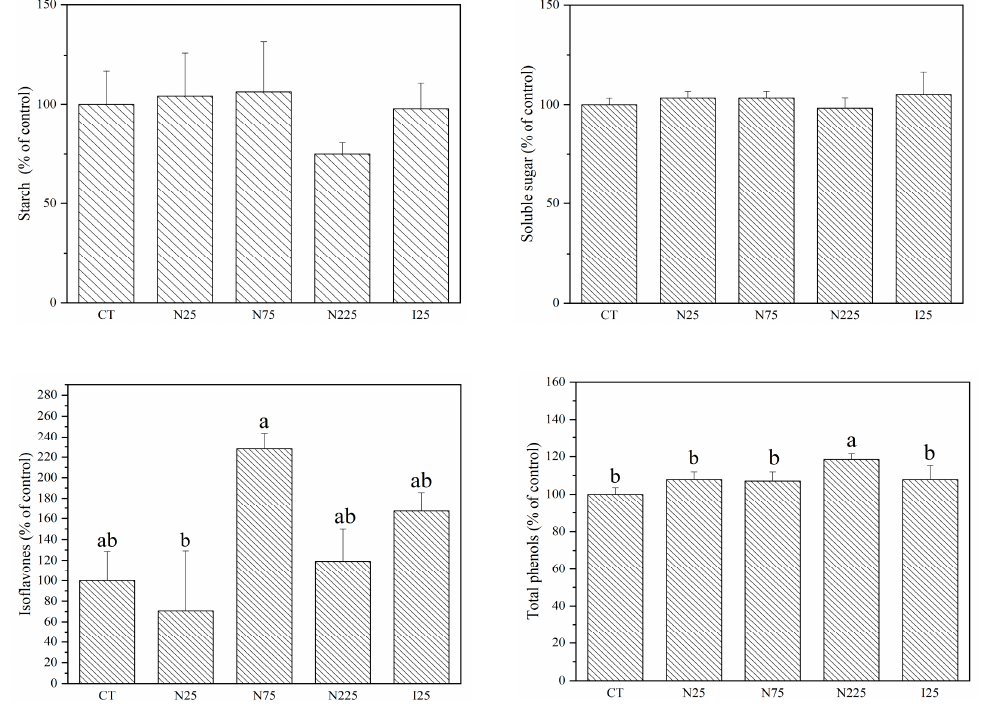
Figure 3. Contents of starch, soluble sugar, isoflavones, and total phenols in the soybean seeds harvested from plants cultivated in CeO 2 NPs/CeCl 3 -amended soil. CT: control; N: CeO 2 NPs; I: CeCl 3 . Different letters stand for statistical differences between treatments at p ≤ 0.05.